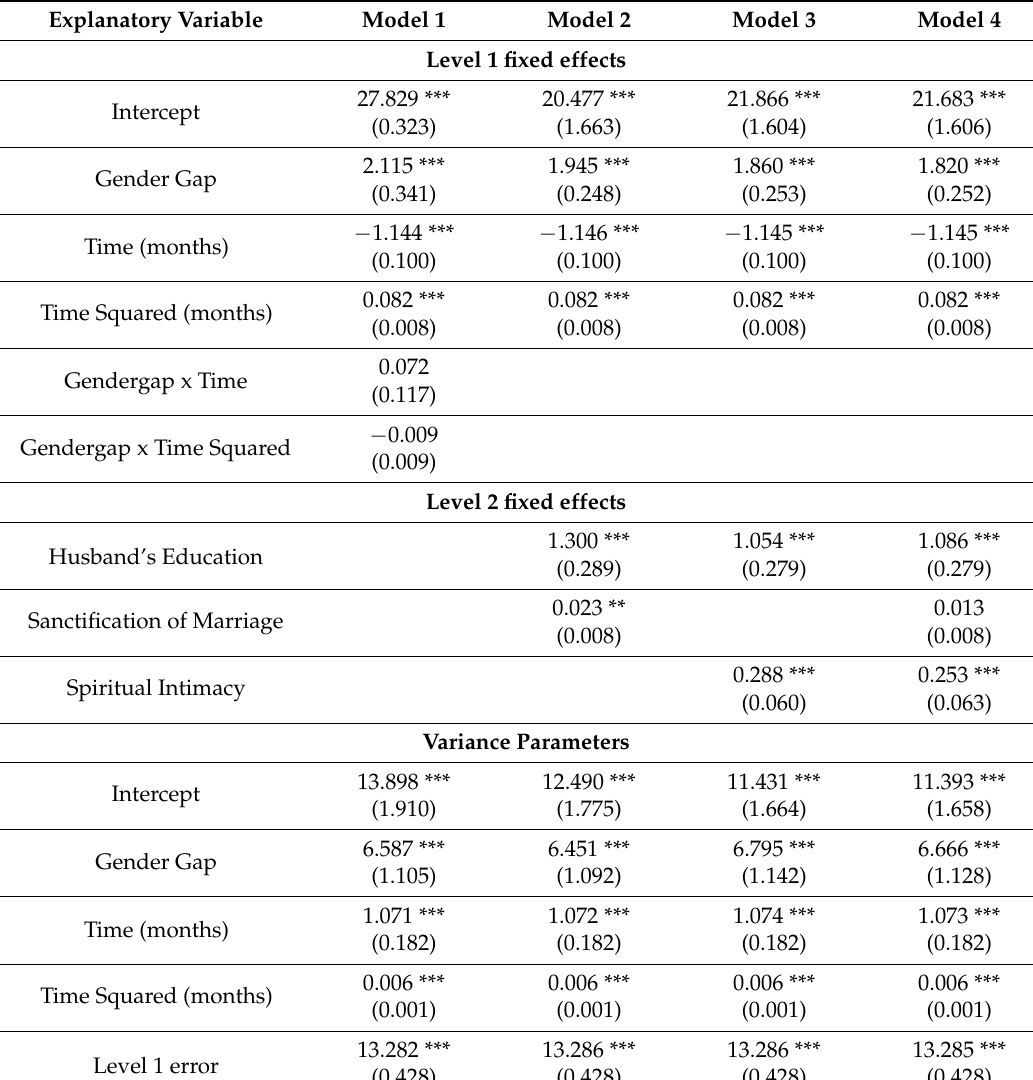
Table 3. Restricted maximum likelihood coefficient estimates (standard errors) for curvilinear mixed- effects models of emotional